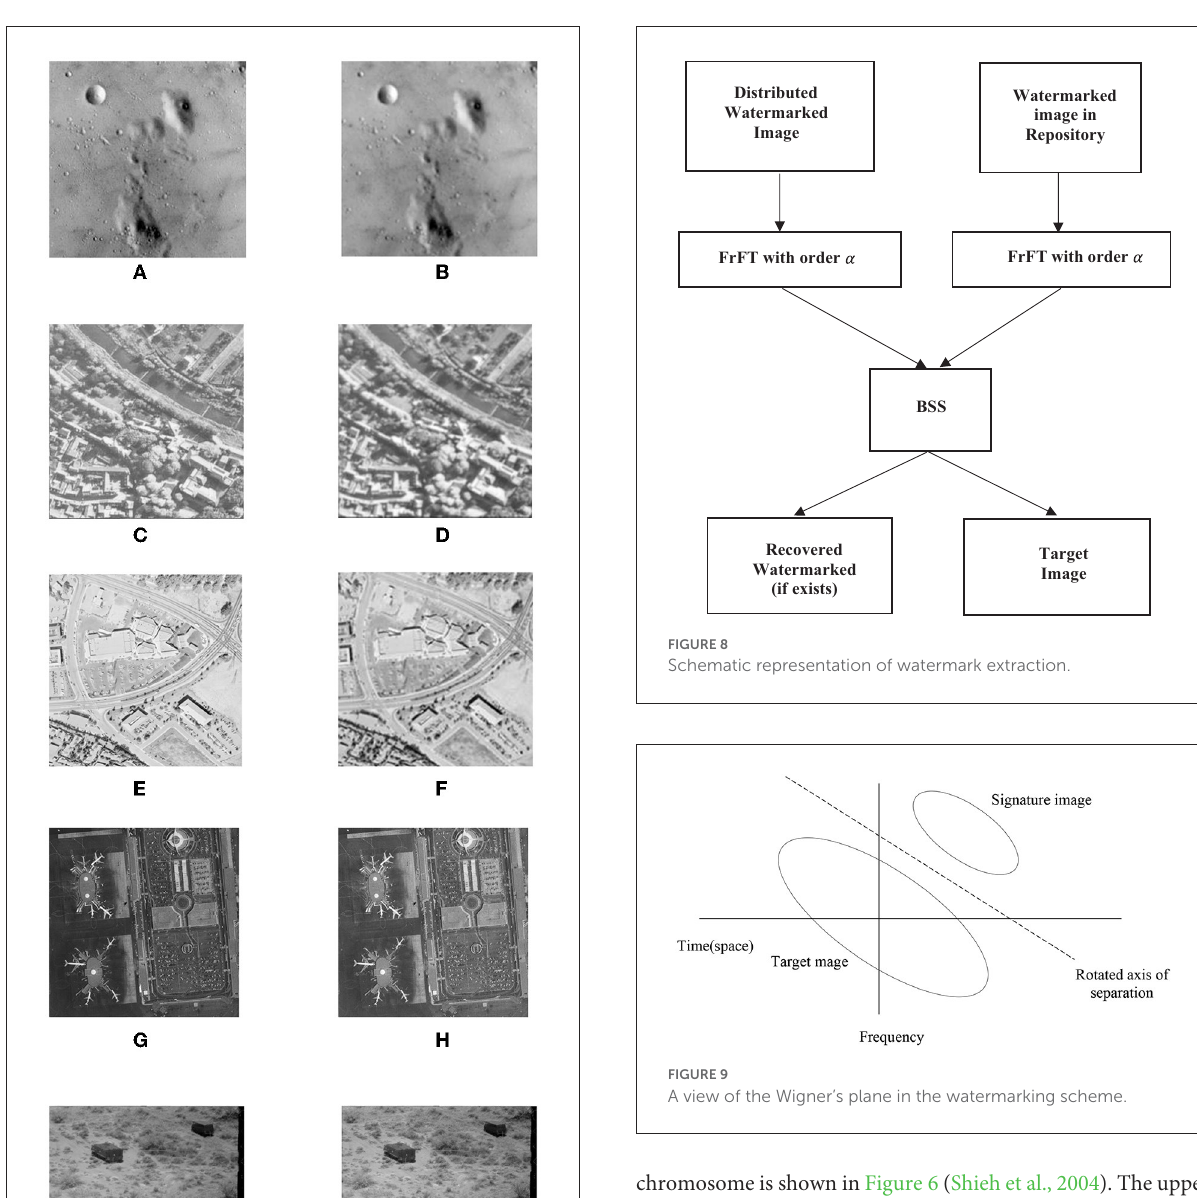
chromosome is shown in Figure 6 (Shieh et al., 2004). The upper limit of the coefficients was restricted to 500 for experimental purposes. The fitness function used to converge the search is defined as the average RMSE of the two images in comparison to the original target image and is mathematically defined as 1 F = 2 " represents the original image and ˆ T i ( x , y ) represents one of the watermarked images. The images are considered of size M × N for generality, but in our experiments, only square images were used for the sake of